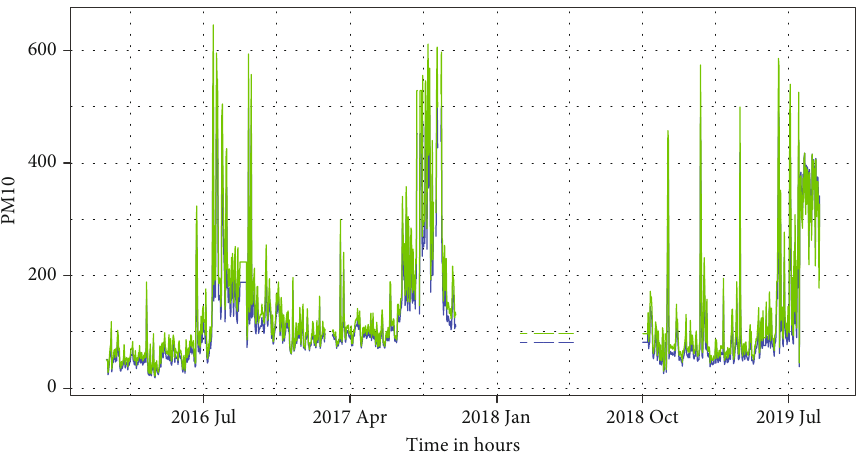
Figure 4: Time series plots of the true (blue) and fi tted values (green) at one randomly chosen location (Qatar University).